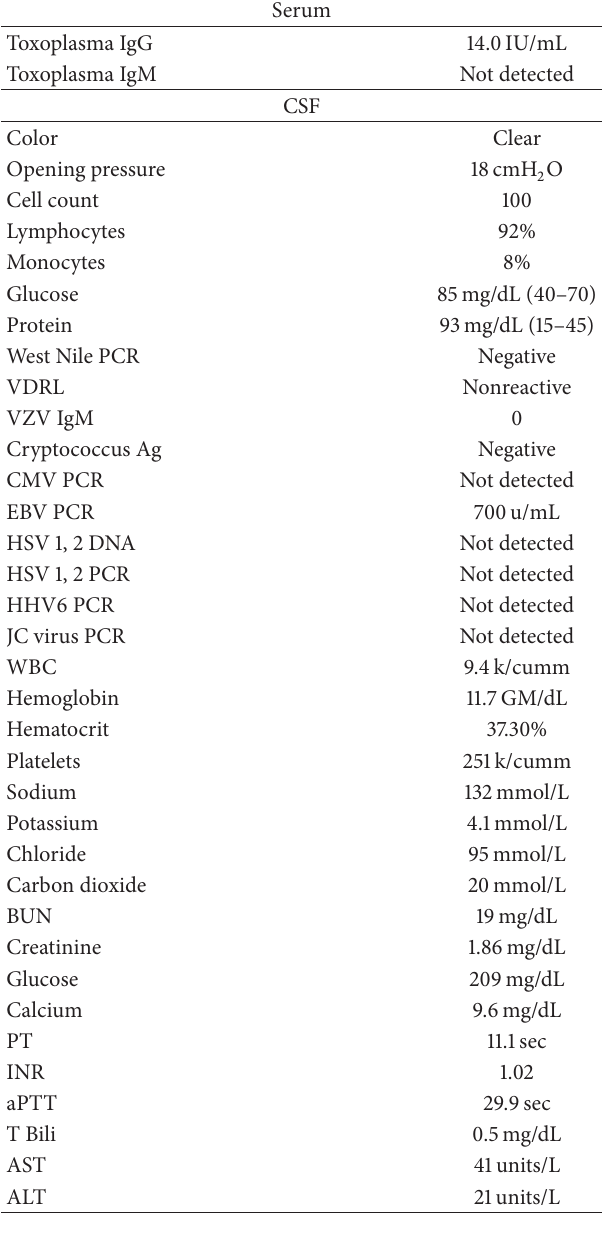
Table 1: Lab values/infectious work-up.